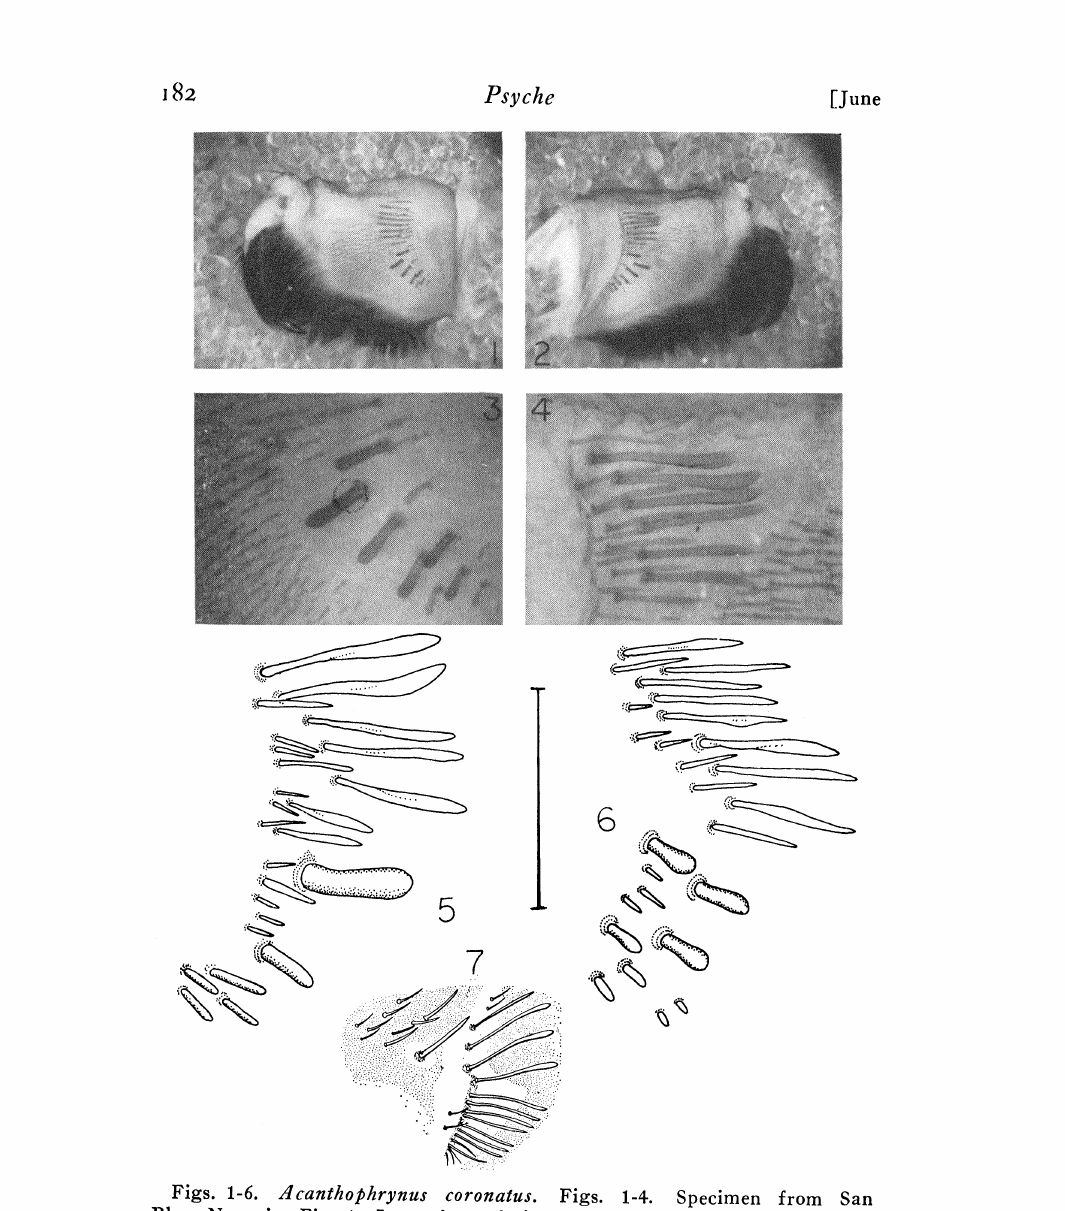
Figs. 1-6. ./lcanthophrynus coronatus. Figs. 1-4. Specimen from San Blas, Nayarit. Fig. 1. Inner faoe of right ehelieera. Fig. 2. Inner face of left ehelieera. Fig. 3. Plectrum of right ehelieera. Fig. 4. Lyre of left ehelieera. Fig. 5. Specimen from San Mareos, Jaliseo, stridulating apparatus of left ehelieera. Fig. 6. Specimen from Mazatlan, Sinaloa, stridulating apparatus of left ehelieera. Fig. 7. Musicodamon atlanteus, stridulating apparatus of left ehelieera (after Fage, 1939), same orientation as Figs. and 6. Scale line mm for Figs. and 2, 2.1 mm for Figs. 3-6. Fig. 7 not to